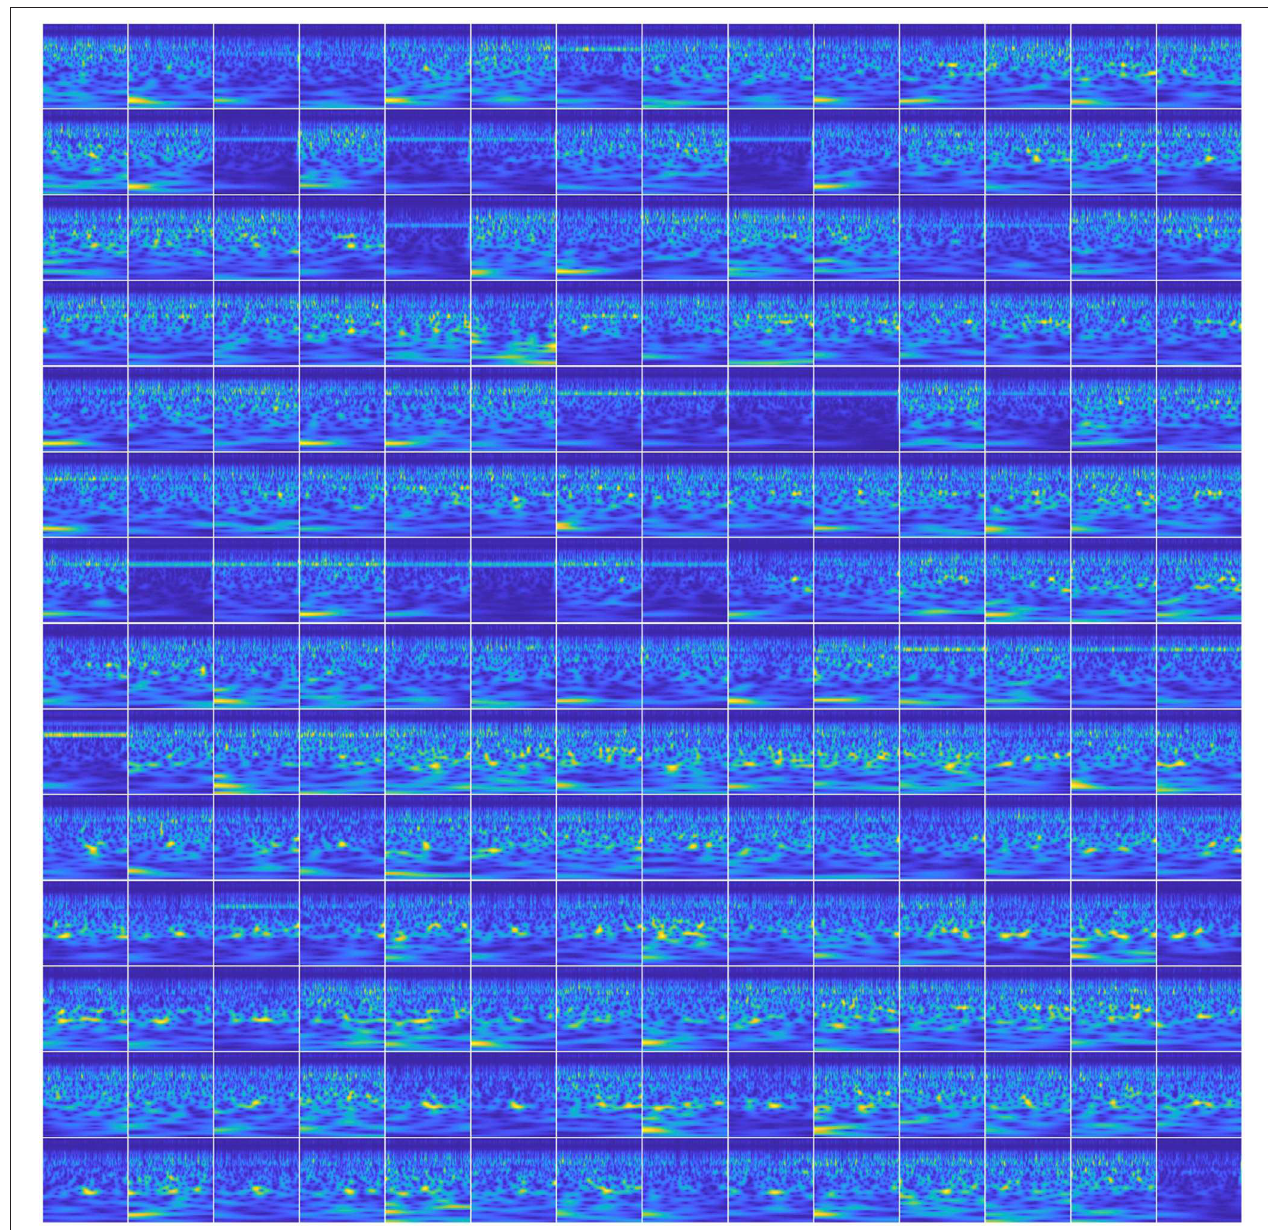
FIGURE 7 | Scalogram matrix of neural signal. The image represents a 14 × 14 matrix of scalogram images to represent the whole brain dynamics in a single image. This is when the subject was speaking “Do you understand me” for a single